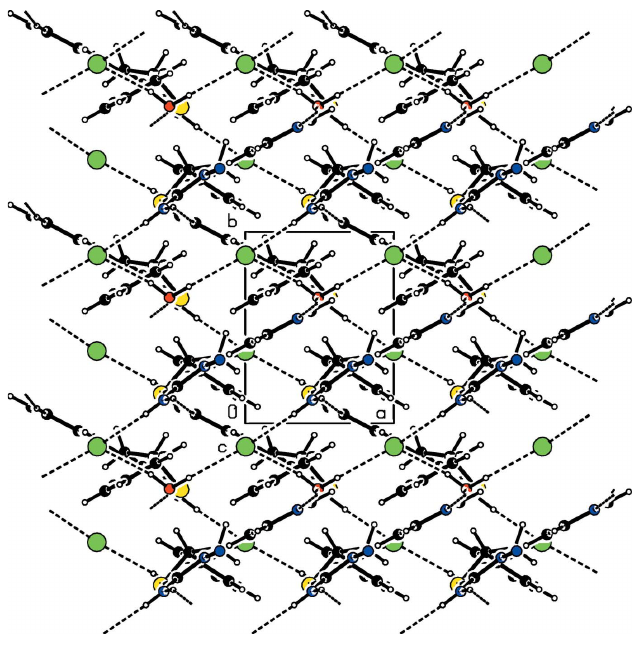
Figure 3 A view of the packing and intermolecular hydrogen bonding of the title compound along the c axis.